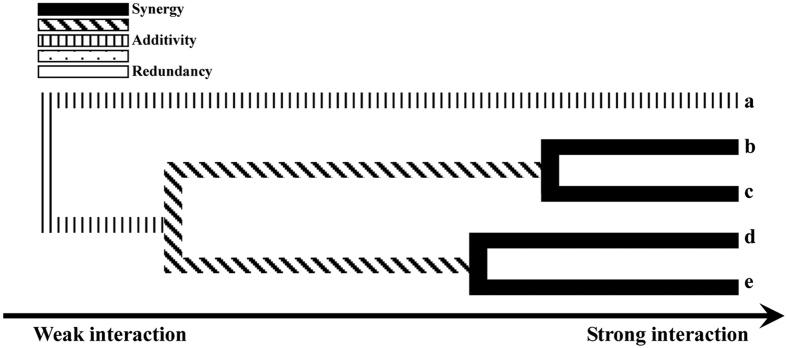
Dendrogram of gene-gene interaction for breast cancer risk.(a) MTRRrs1801394; (b) MTRRrs1602036; (c) MTRrs1805087; (d) MTHFRrs1801131; (e) MTHFRrs1801133.